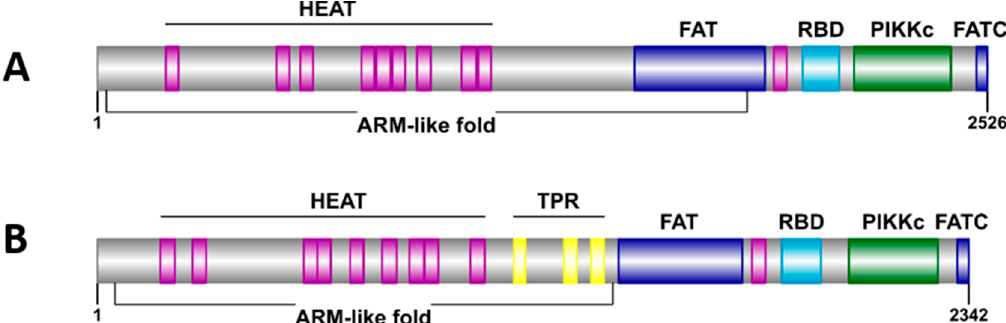
Figure 2. Schematic representation of the Eh FRAP ( A ) and Eh TOR2 ( B ) domain organization. Protein features were identified by primary structure analysis. While the tetratricopeptide repeats (TPR) are in yellow, the colors for HEAT, FAT and FATC, RBD, and PIKKc were as in Figure 1. Drawings generated with the IBS program.